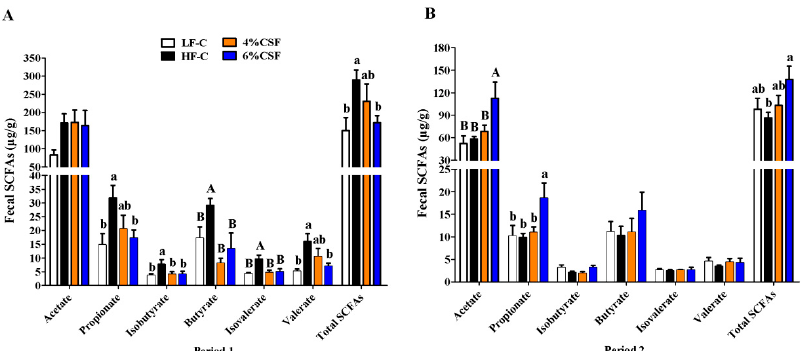
Figure 5. Effect of CSF supplementation on the production of short-chain fatty acids (SCFAs) during the two consecutive periods. Fecal SCFAs (n = 5–7) as measured by gas chromatography during period 1 ( A ) and period 2 ( B ). Data are expressed as mean ± SEM. Statistical significance was assessed by Tukey’s test for multiple comparisons. ab means in the same bar without a common letter differ at p < 0.05; AB means in the same bar without a common letter differ at p < 0.01.